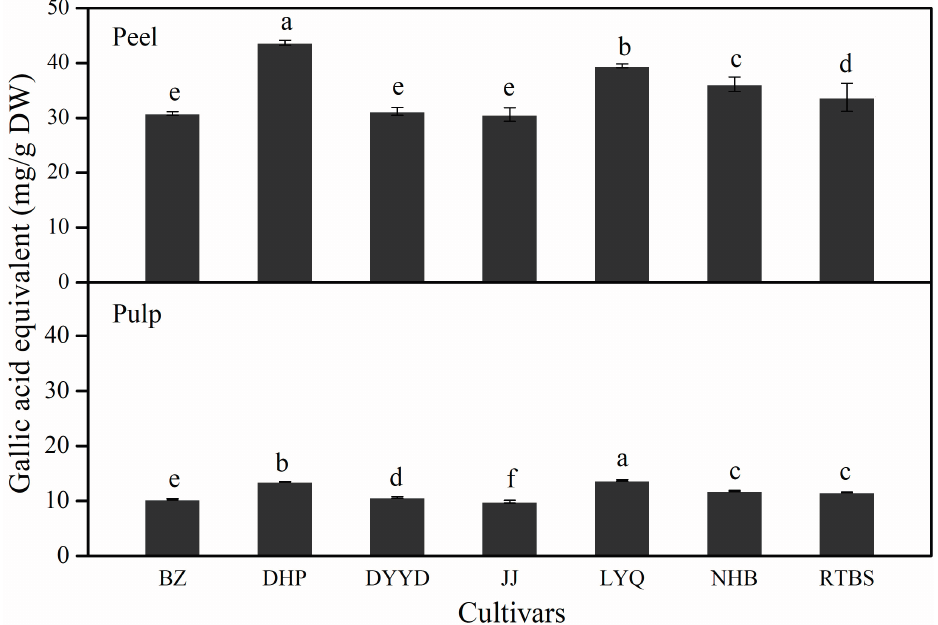
Figure 1. Total phenolic contents of the peel and pulp extracts of the seven loquat cultivars. Data are expressed as mean ± standard deviation of triplicate samples; Different letters within the same fruit tissue (peel or pulp) represent significant differences at p < 0.05; Cultivar abbreviations were shown in Table